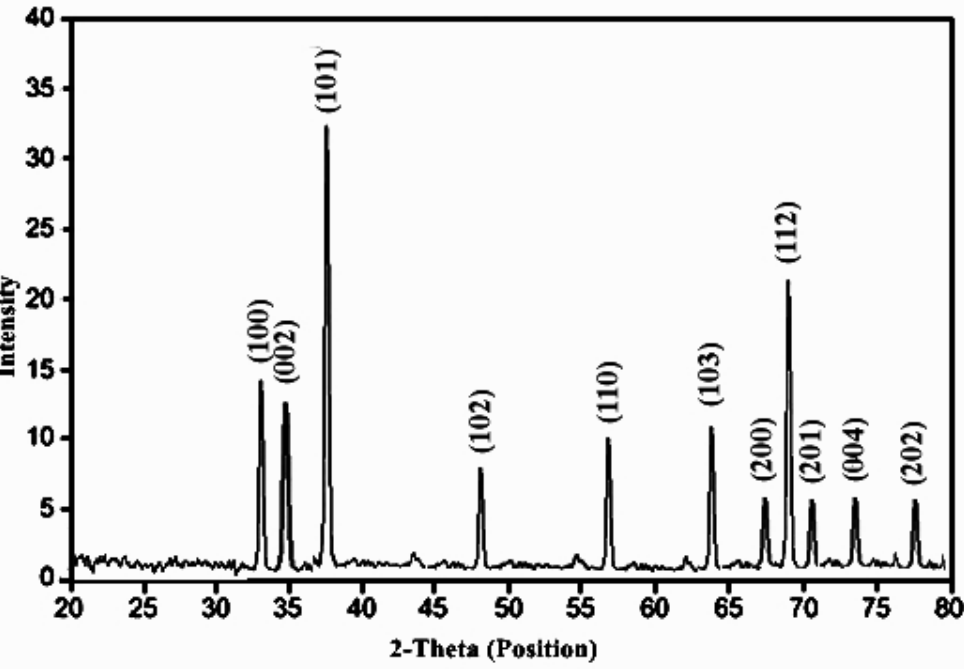
Figure 1. XRD analysis spectrum patterns confirming the synthesis of ZnO nanoparticles.